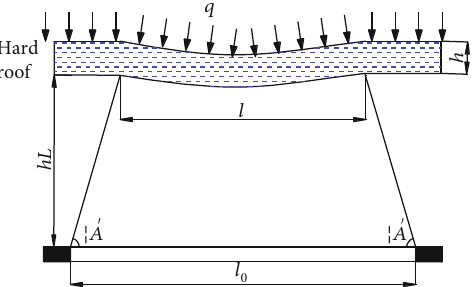
Figure 4: Relationship between the hanging length and mining length.